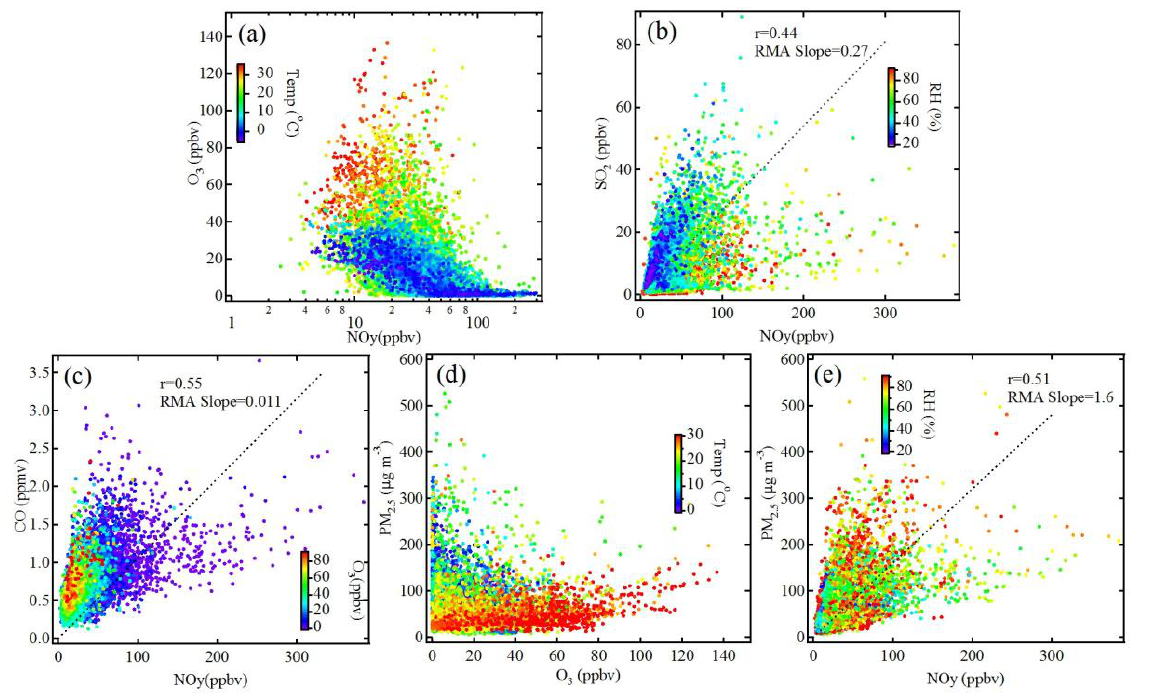
Fig. 4. Scatter plots of (a) O 3 –NO y color-coded with air temperature, (b) SO 2 –NO y color-coded with relative humidity, (c) CO–NO y color- Figure 4. Scattering plots of ( a ) O 2 coded with O 3 concentrations, (d) PM 2 . 5 –O 3 color-coded with air temperature, and (e) PM 2 . 5 –NO y color-coded with RH. color-coded with relative humidity, ( c ) CO-NO PM -O color-coded with air temperature, and ( e ) PM Figure 4d gives a scatter plot of PM 2 . 5 and O 3 color-coded 2.5 3 with air temperature. Interestingly, a negative correlation can be found for low air temperature samples but a pronounced positive correlation existed for high temperature data